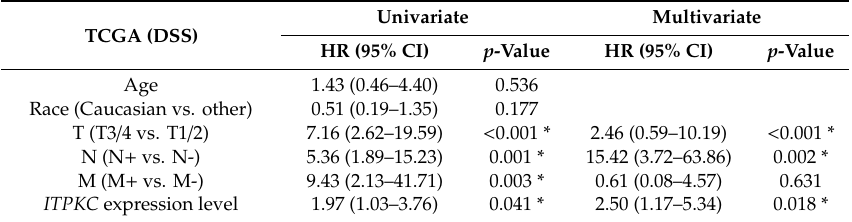
Table 2. Survival analyses of ITPKC expression and other factors in the TCGA cohort. Univariate TCGA (DSS)